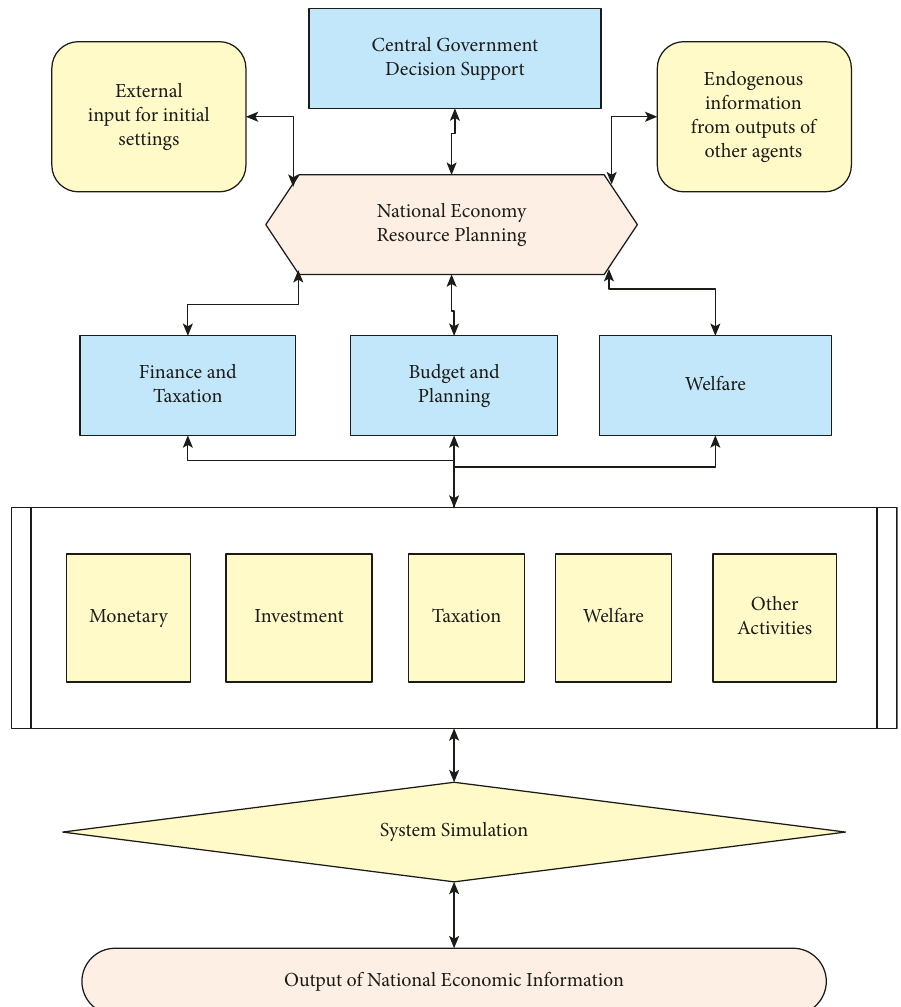
Figure 7: Overview of the process and structure of government module (source: Guangzhou Milestone Software Co., Ltd.,